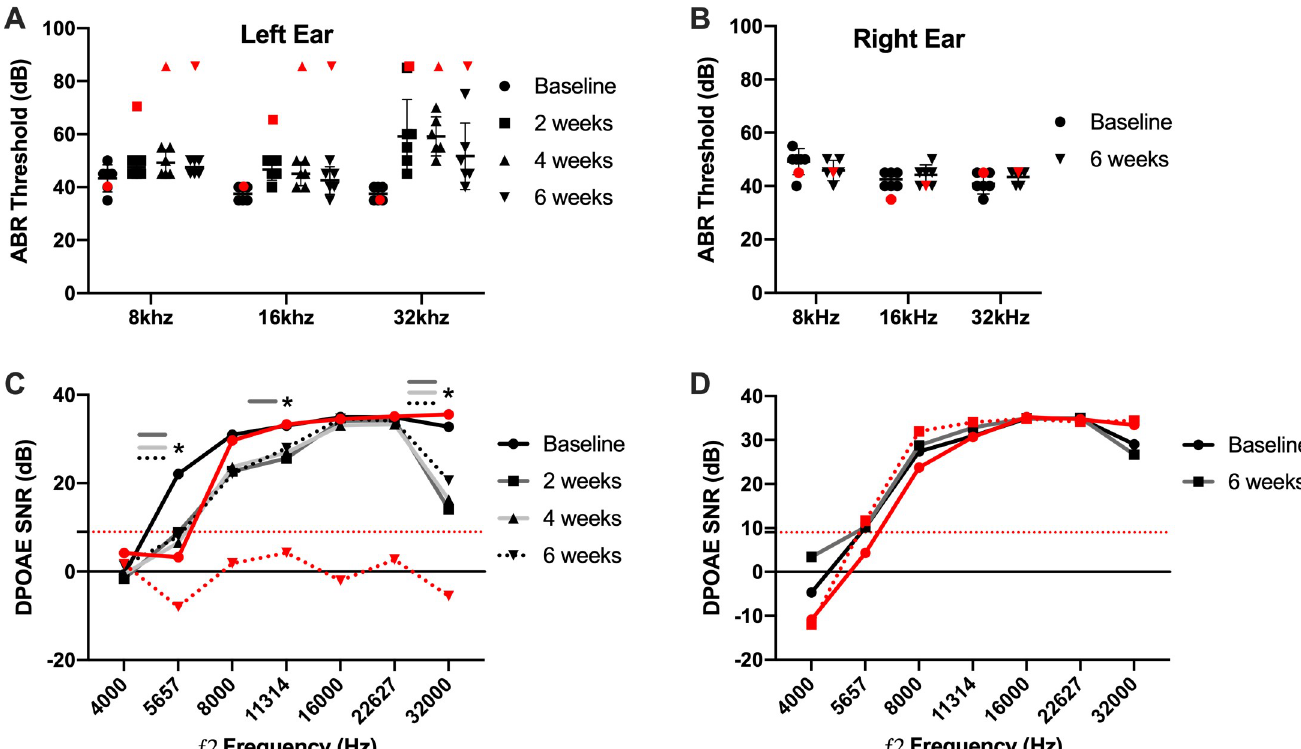
Fig 12. ABR and DPOAE measures of hearing preservation. Left, implanted (A) and right, non-implanted (B) ear ABR thresholds are plotted by individual subject with representative black symbols according to testing day. The black horizontal bars represent mean values. Red symbols indicate the 1 subject excluded secondary to significant hearing loss post-implantation. ABR thresholds maintained within 15 dB SPL of baseline values for all experimental subjects (black symbols) at the 8 and 16 kHz frequencies. There were no significant differences between timepoints at any frequency (p > 0.05). Error bars represent SD for the 6 subjects meeting hearing preservation criteria. (C) and (D) show mean DPOAE signal to noise ratio (SNR) for the left (implanted) and right (non-implanted) ears, respectively. ‘ � ’ denotes statistically significant (p > 0.05) difference from baseline SNR values at respective timepoints. Within our system, a SNR � 9 is considered an intact DPOAE; this threshold is denoted by the red, dotted horizontal line. The solid red line represents baseline values for the 1 excluded subject and the dotted red line represents final 6-week DPOAE SNR values.